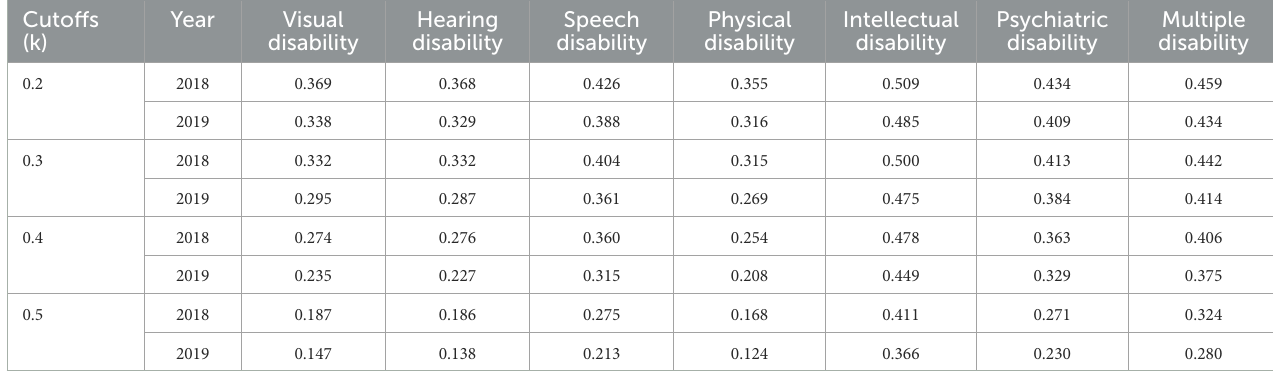
TABLE 4 Decomposition results of MPI for different poverty cutoffs: different disability categories. Cutoffs